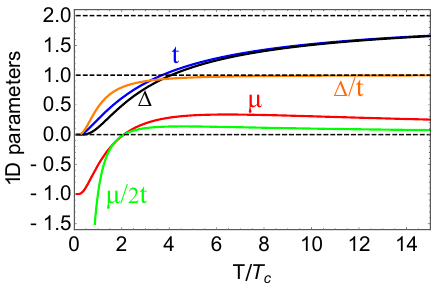
[ Eq. 32 ] and the 1D quantum model H Figure 23: Mapping between the 2D classical model H ABB 1D [ Eq. 65 ] . The parameters of the 1D quantum model depend on those of the classical model according to Eq. 66, and the relationship is shown for J 1B / J 1A = 1.5. As T → 0 then t → 0, µ → − 1, ∆ → 0, µ/ 2 t → −∞ and ∆ / t → 0. The phase transition occurs when µ/ 2 t = − 1. In the limit T → ∞